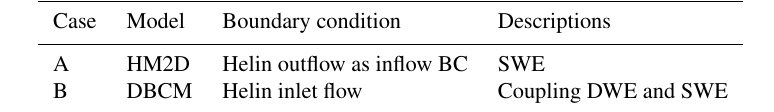
Table 2. Simulation scenarios.